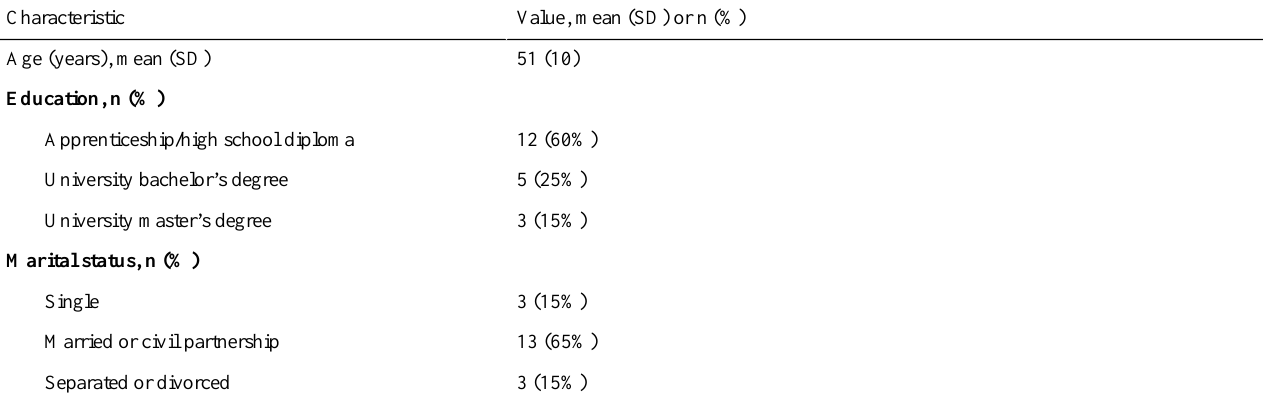
Table 1. Characteristics of the participants